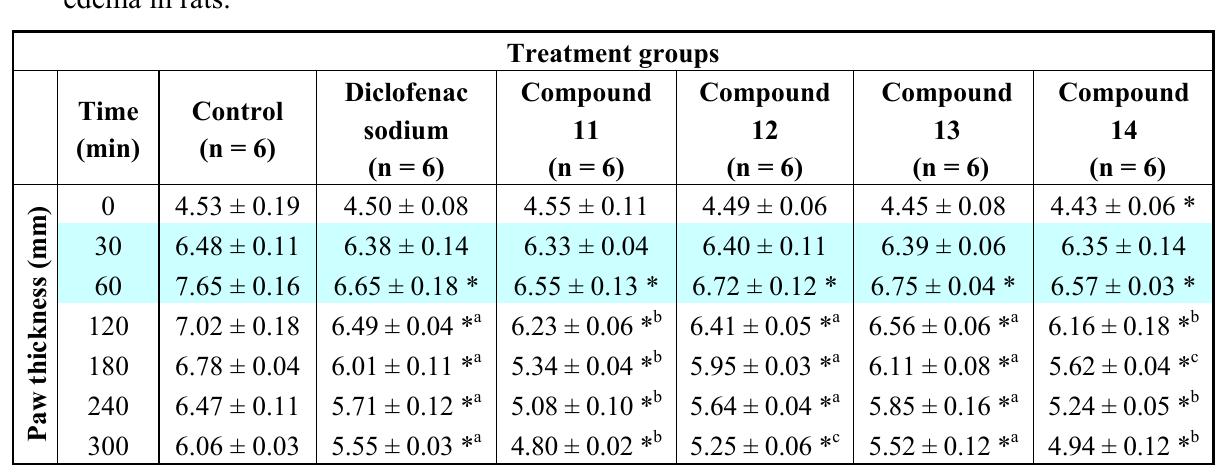
Table 2. Effect of Control, Diclofenac and Compounds 11 – 14 on egg-white induced paw edema in rats.